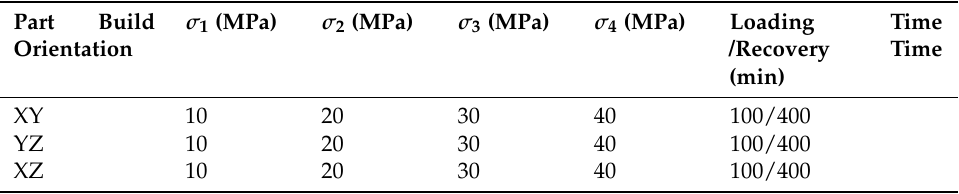
Table 3. Sample design matrix for the creep tests.